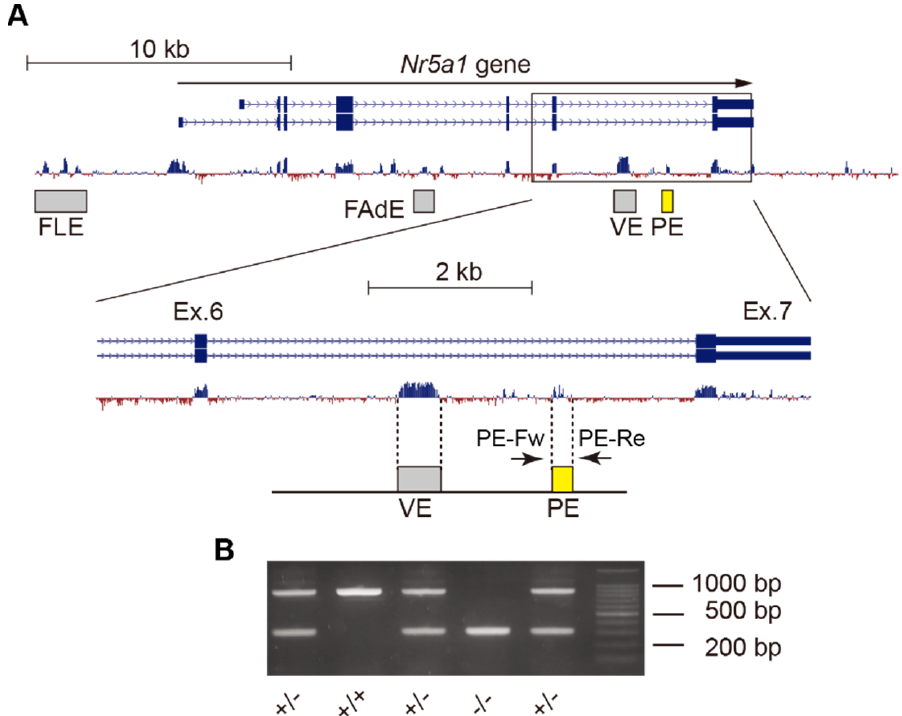
Figure 1. Deletion of the pituitary enhancer (PE) of Nr5a1 by genome editing. ( A ) Nr5a1 comprises seven exons. Several tissue-specific enhancers exist in the intronic and upstream regions of Nr5a1 , such as the fetal Leydig enhancer (FLE), fetal adrenal enhancer (FAdE), ventromedial hypothalamic nucleus enhancer (VE), and PE. ( B ) The PE (yellow filled box) in the sixth intron of the gene was deleted by genome editing, and genotyping PCR with the primers PE-Fw and PE-Re confirmed that the region was successfully removed from the genome.